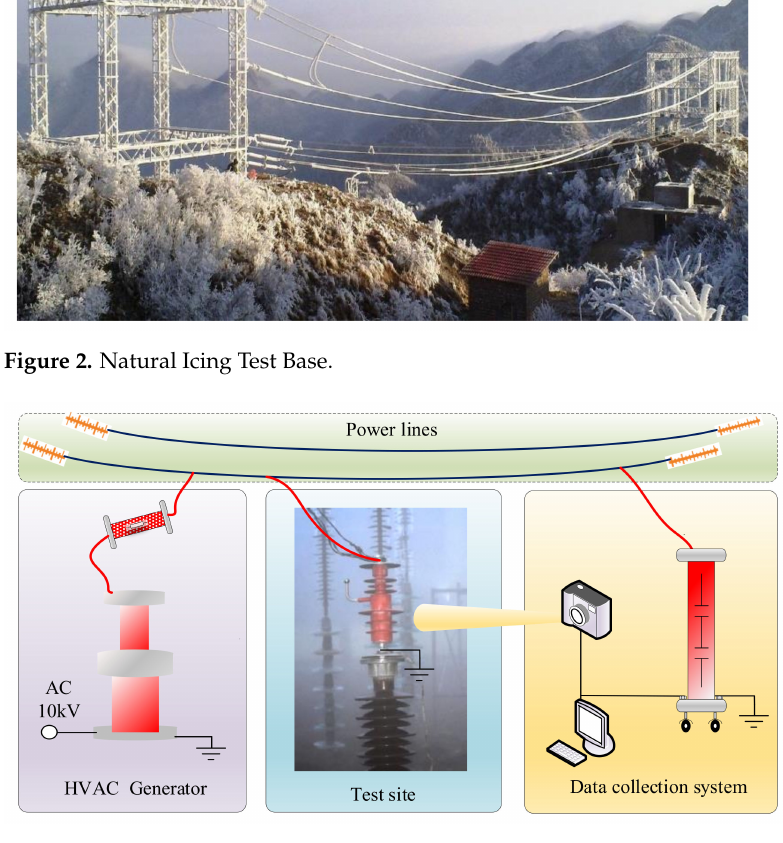
Figure 3. Schematic diagram of natural icing test.